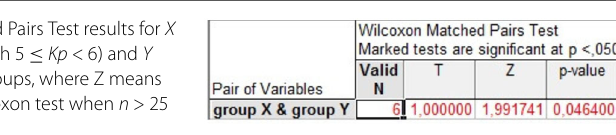
Figure 10 Wilcoxon Matched Pairs Test results for X (failures linked to the days with 5 ≤ Kp < 6) and Y (with Kp index values ≥ 6) groups, where Z